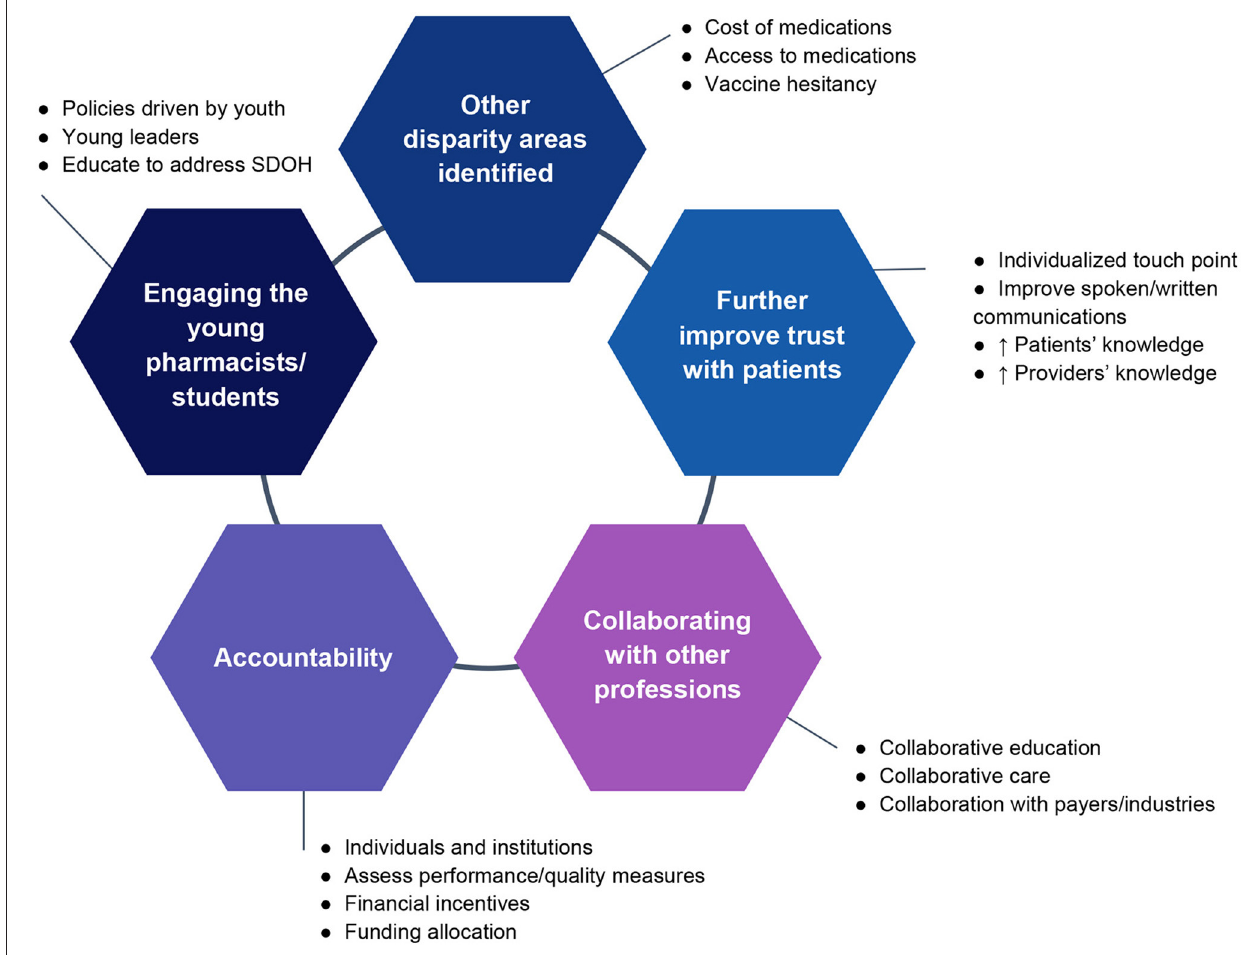
FIGURE 1 | Key issues raised during group discussions. SDOH, social determinants of health.